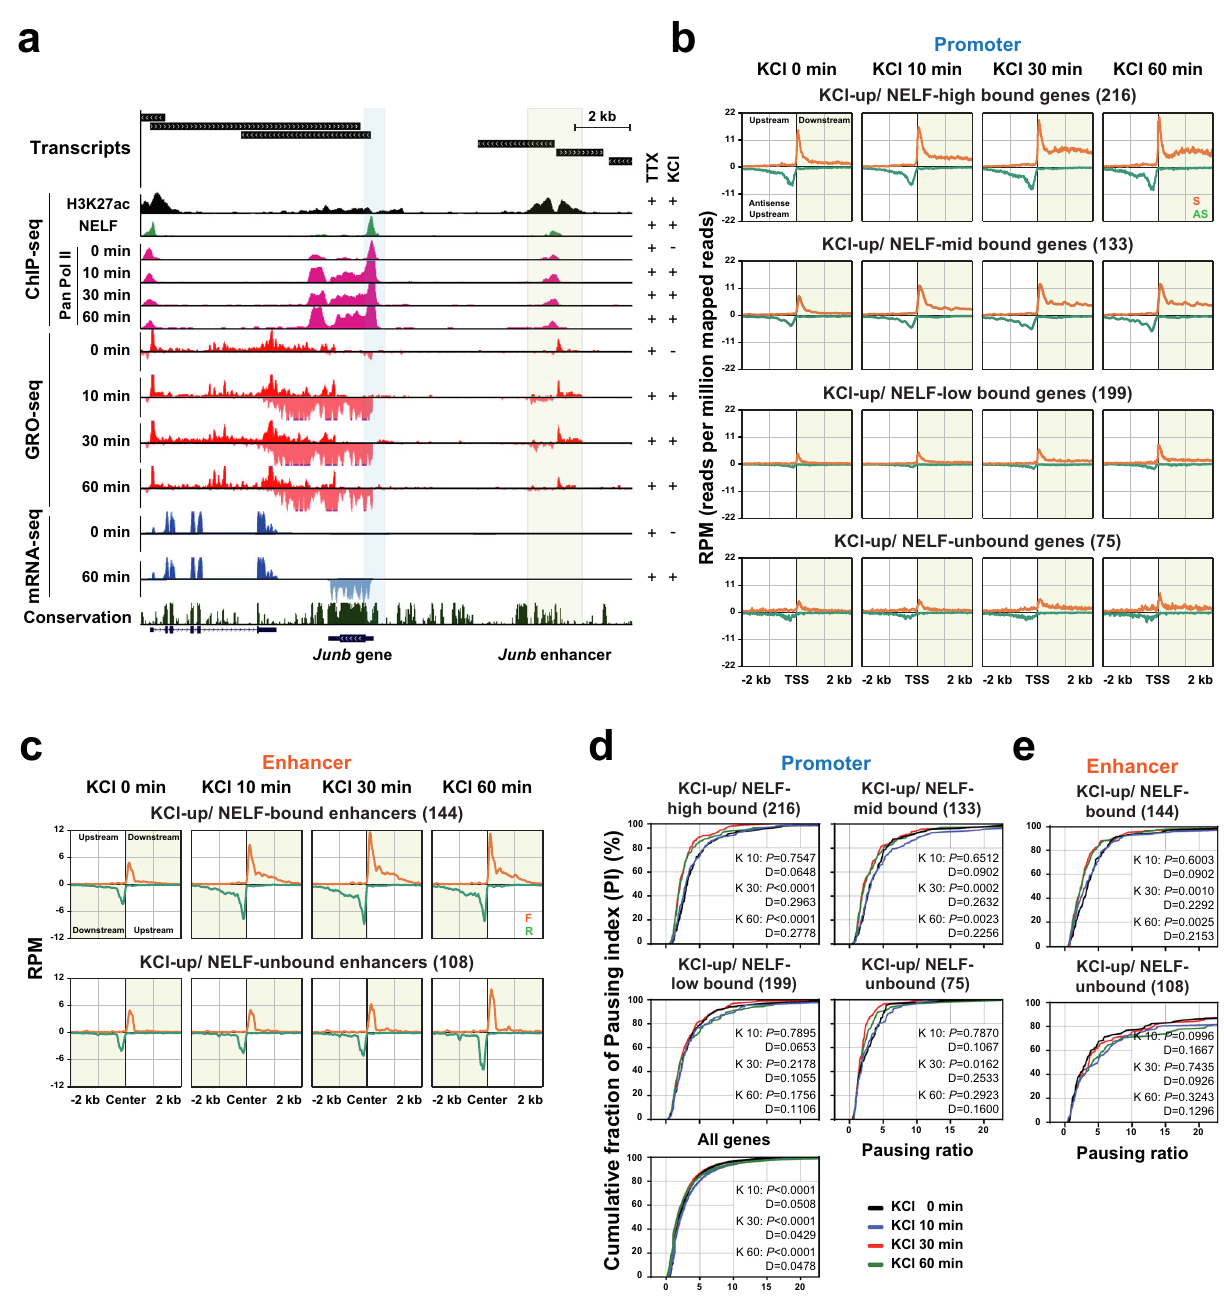
Fig. 7 NELF occupancy is correlated with Pol II pause release and causal to transcription induction in vivo. a Example track that shows an activity- induced gene, Junb (Blue shaded at its promoter) and its nearby enhancer (Yellow shaded area). Transcript units determined by de novo transcript calls are shown on the top together with tracks for ChIP- (H3K27ac, NELF-E, and Pan Pol II), GRO-, and mRNA-seq. b , c The average GRO-seq pro fi les of four different gene groups based on the levels of NELF binding (NELF-high [216], -mid [133], -low [199], or -unbound [75]) ( b ) and two different enhancer groups (NELF-bound [144] or -unbound [108] ( c ). The pro fi les are shown for ±2 kb regions centered on the TSSs or the enhancer centers upon 0, 10, 30, and 60 min KCl stimulation. Orange lines denote the sense strand at promoters and the forward strand at enhancers. Green lines denote the anti-sense strand at promoters and the reverse strand at enhancers. d , e Pausing index (PI) pro fi les of four different gene groups based on their levels of NELF binding with all genes ( d ) and KCl-up/NELF-bound (144) or -unbound (108) enhancers ( e ). Each gene group is analyzed at four time points (0, 10, 30, and 60 min KCl). The PI is de fi ned in Supplementary Fig. 11d. Statistical signi fi cance between cumulative probability graphs was determined by the Kolmogorov – Smirnov test. Source data for ( b – e ) are provided in a Source Data fi at all. Second, preferential binding of NELF to guanosines was NELF-E RNA binding, underscoring the preference of NELF for also reported for the D. melanogaster homolog of NELF-E and its guanosines. Interestingly, a comparison of the sequences of fl y isolated RRM domain 41 . The study identi fi ed the sequence and human NELF-E reveals that the D. melanogaster homolog is CUGGAGA as NELF binding element (NBE). Mutating all gua- lacking the RD repeat domain 41 . This fact might explain why human NELF-E binds RNA in a less sequence-speci fi c manner nosines to adenosines within the NBE abolished D. melanogaster